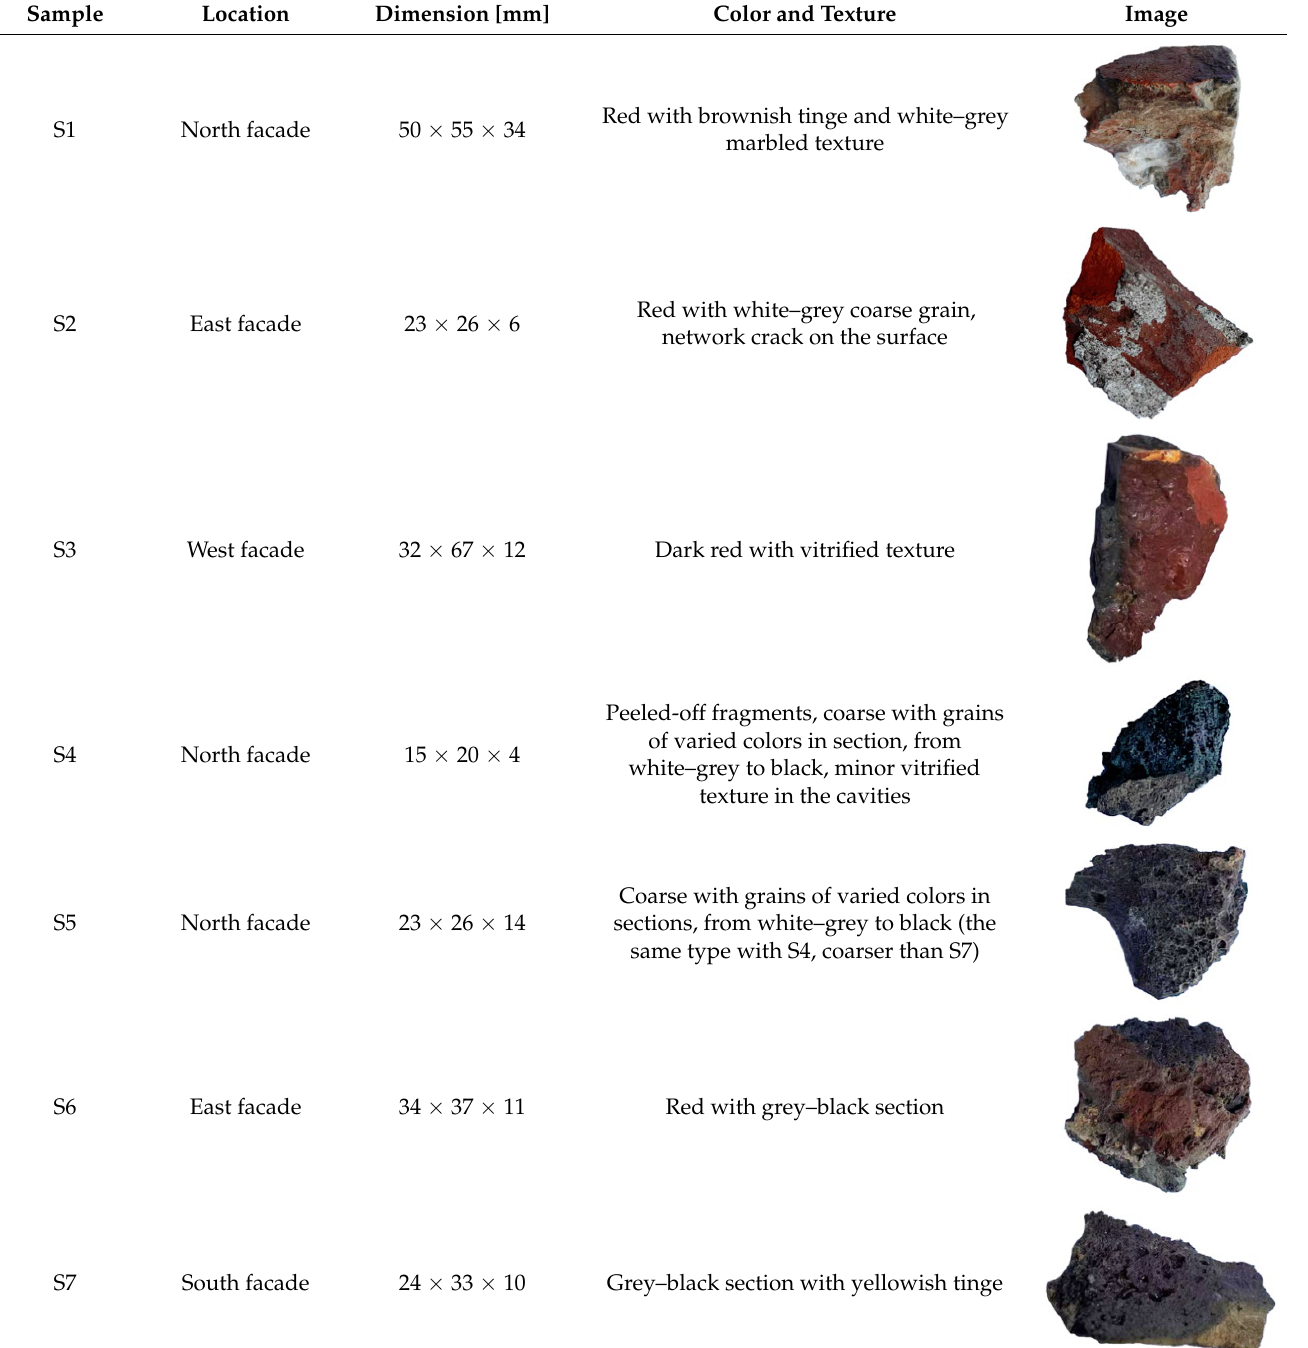
Table 1. Brick sample mark, location and macroscopic observation.